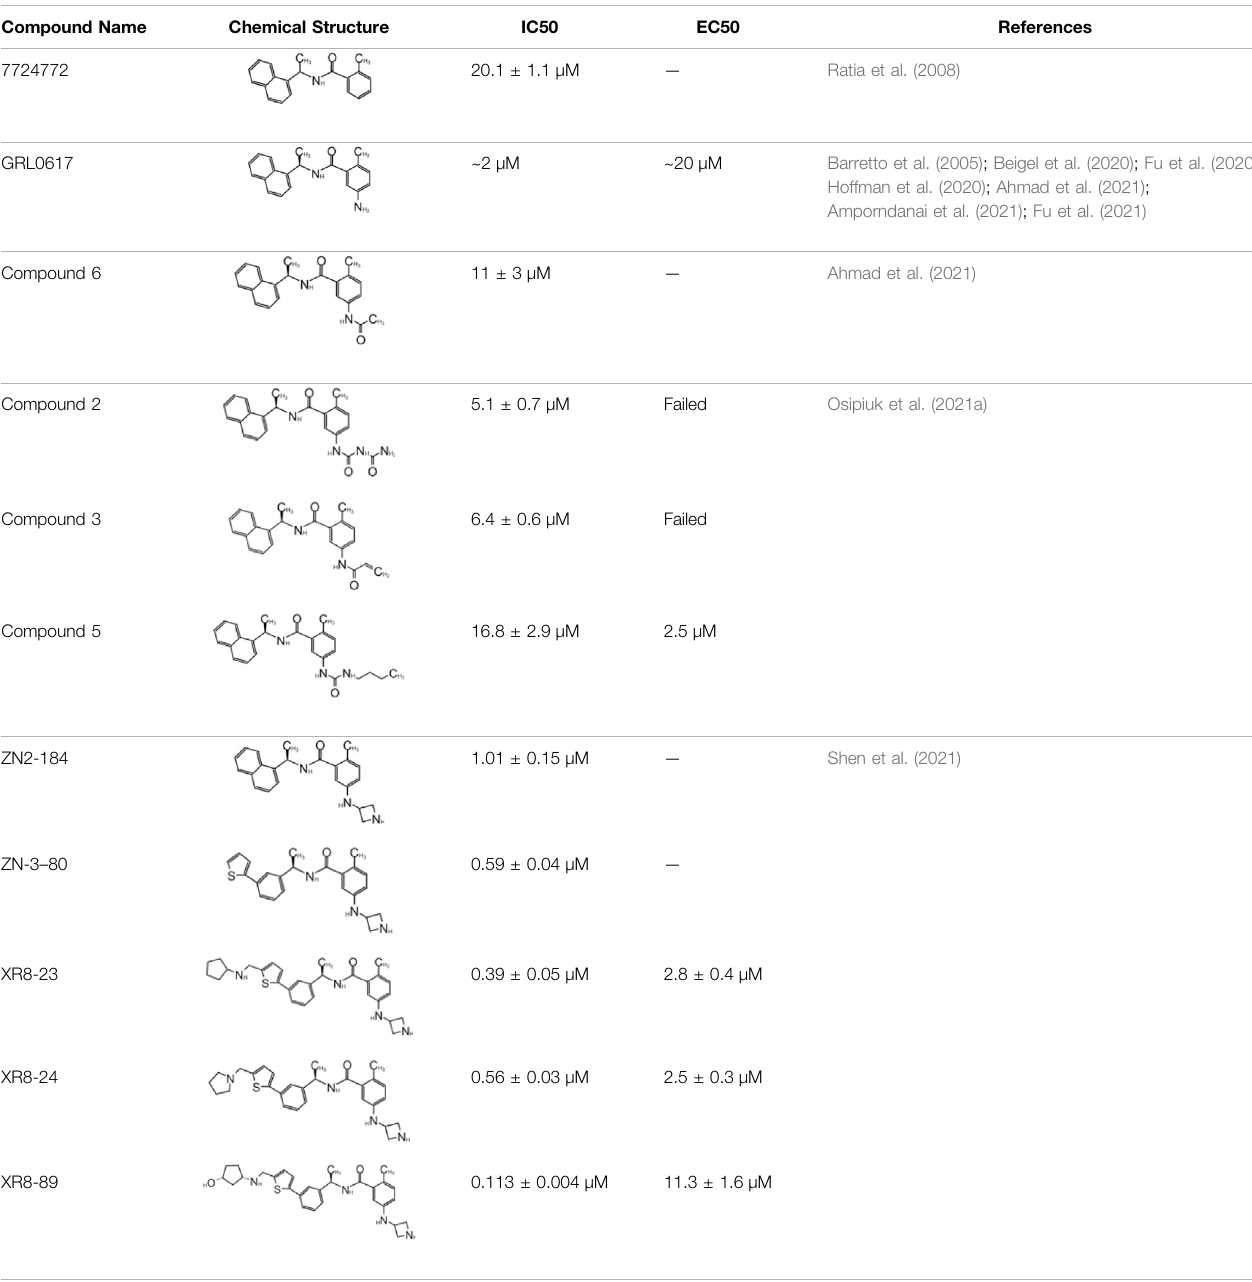
TABLE 1 | GRL0617-like inhibitors